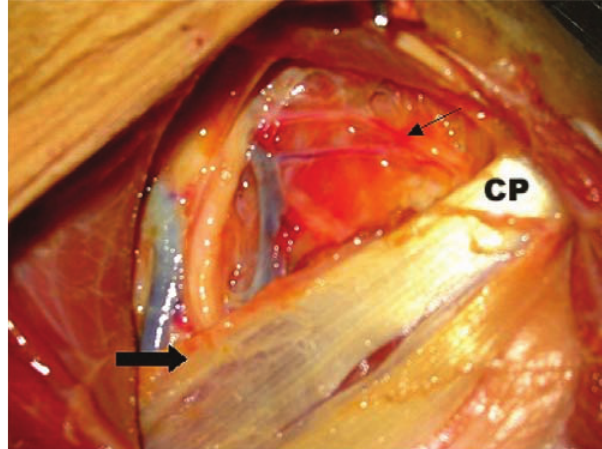
Figure 3 - Relationship between the coracoid process (CP), joint tendon, and neurovascular structures: musculocutaneous nerve (wide arrow) and acromial artery (narrow arrow)